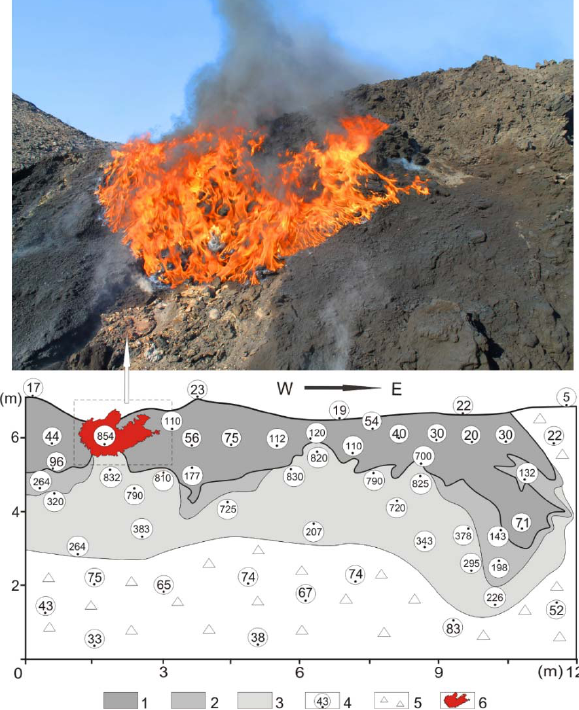
Figure 6. Section of pyrogenesis mass of coal-bearing deposits on the eastern hillside of spoil heap Ch-05. The bottom fragment shows the area of high-temperature pyrolysis, occurring under pyrogenesis that promotes coking, and then high-temperature burning of rock fragments and their subsequent caking.